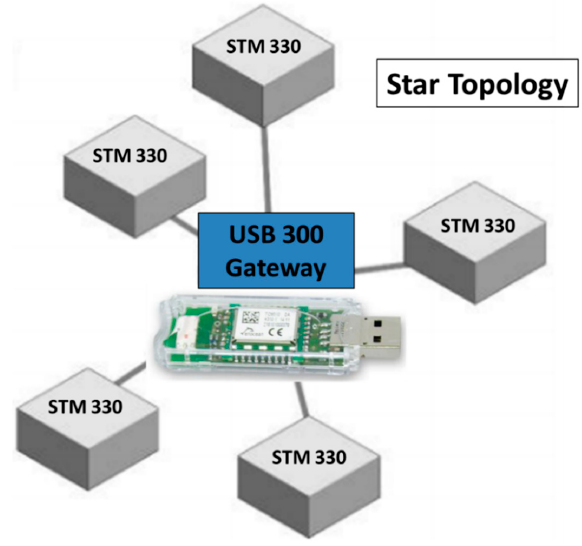
Figure 3. Schematic description of the star topology of the network with the EnOcean’s USB 300 Gateway central module.